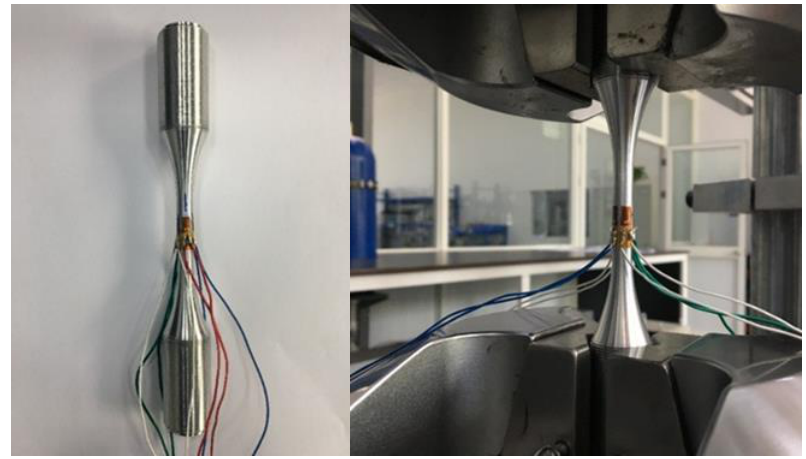
Figure 2. Vibration fatigue experiment platform.